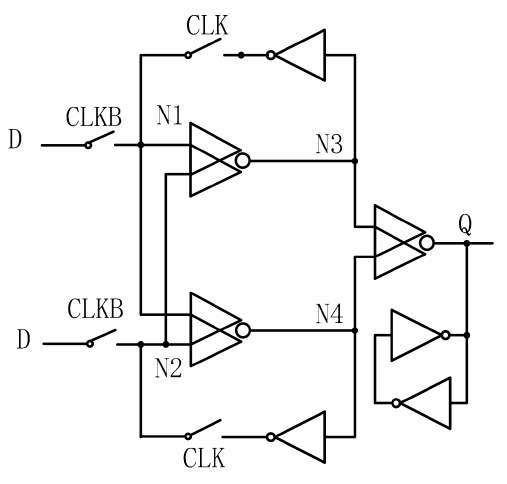
Figure 3. FERST schematic.